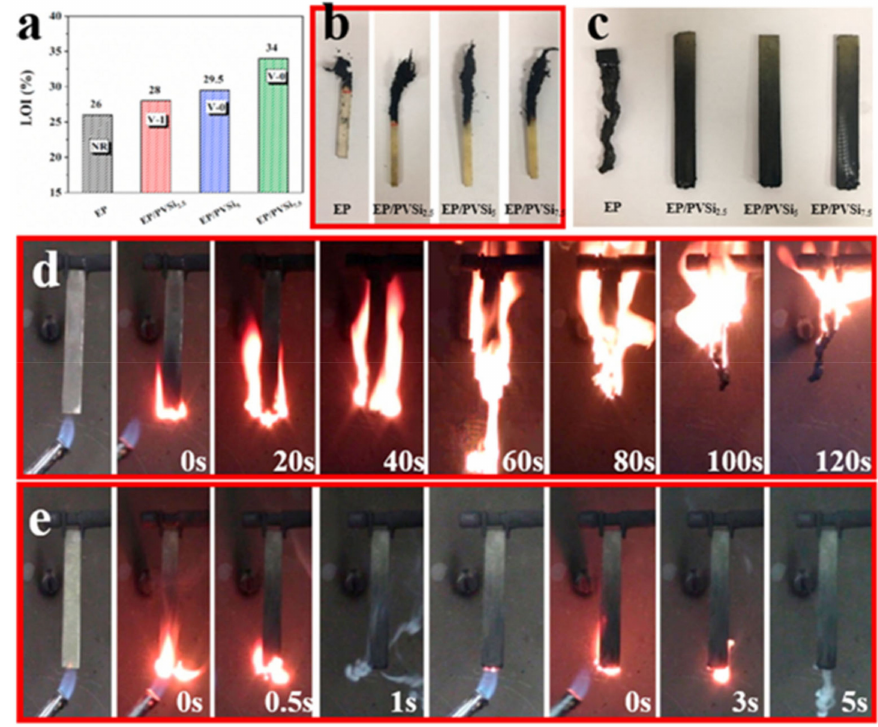
Figure 13. Limit oxygen index (LOI) and UL-94 test ( a ) epoxy matrix (EP) and EP-based composites, ( b ) the residue image of EP and EP-based composites, ( c ) UL-94 vertical burning test, digital photos of ( d ) neat EP, and ( e ) EP/PVSi-5.0. Reprinted with permission from F. Chu et al. [165] Copyright 2020